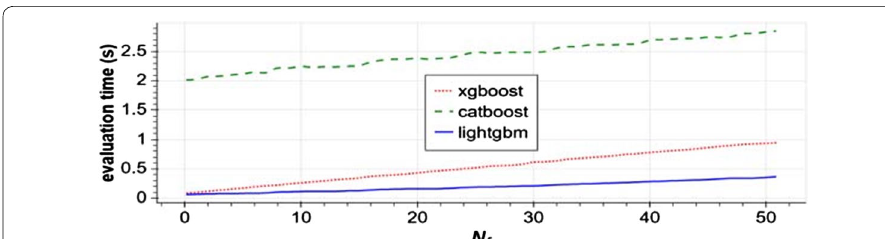
Fig. 5 From [31]; Evaluation (total train and test) time for XGBoost, CatBoost, and LightGBM as number of features increases, average of 100 random customers; shows improvement in CatBoost false positive rate when all summary statistics are employed